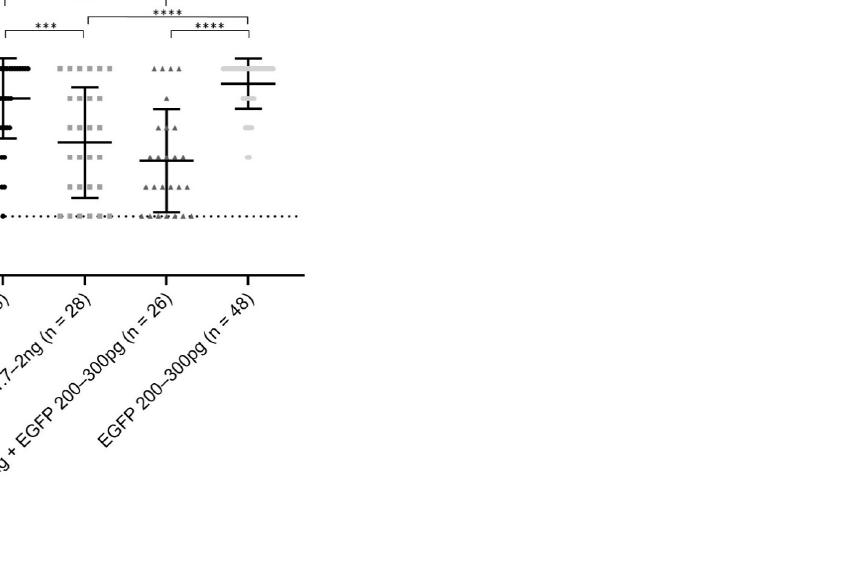
Figure 5. EGFP RNA does not improve visual function of rbm24a knockdown embryos. Automated startle response assay (VIZN) was performed on uninjected, rbm24a knockdown, rbm24a knockdown with EGFP RNA, and EGFP RNA larvae. Knockdown of rbm24a inhibits visual function, which was statistically significant compared to uninjected. Addition of EGFP RNA to rbm24a knockdown does not statistically significantly increase visual function when compared to rbm24a knockdown alone. Injection of EGFP RNA alone does not statistically significantly alter visual function from uninjected. Mann–Whitney *** p < 0.001, **** p < 0.0001. Nonsignificant interactions not shown.